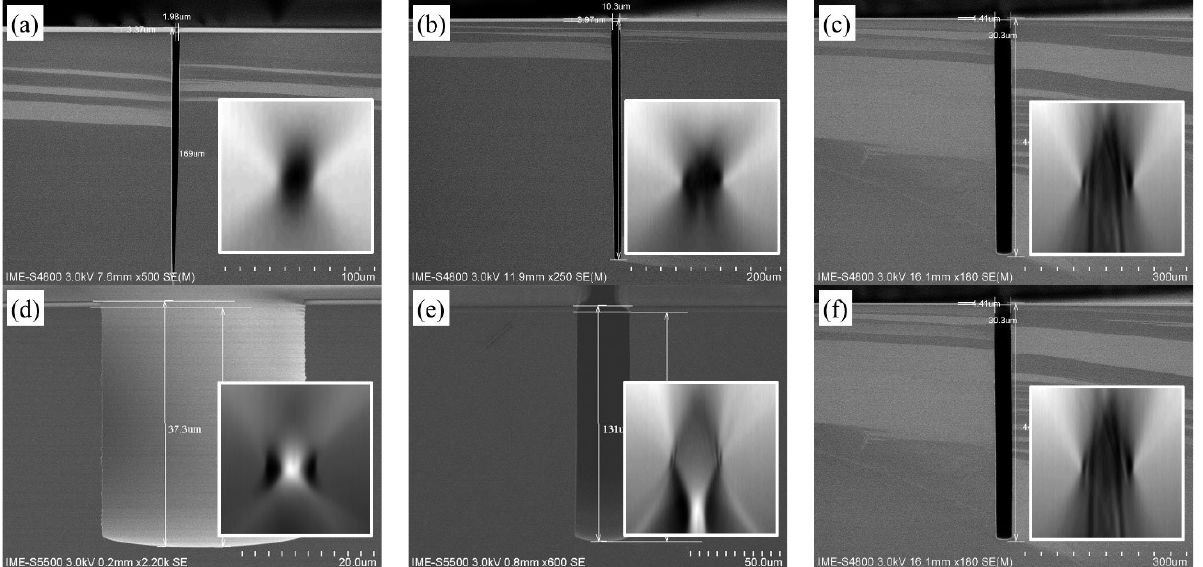
Figure 4. SEM images of MEMS HAR trench sections with width and depth of ( a ) 1.98 μm and 169